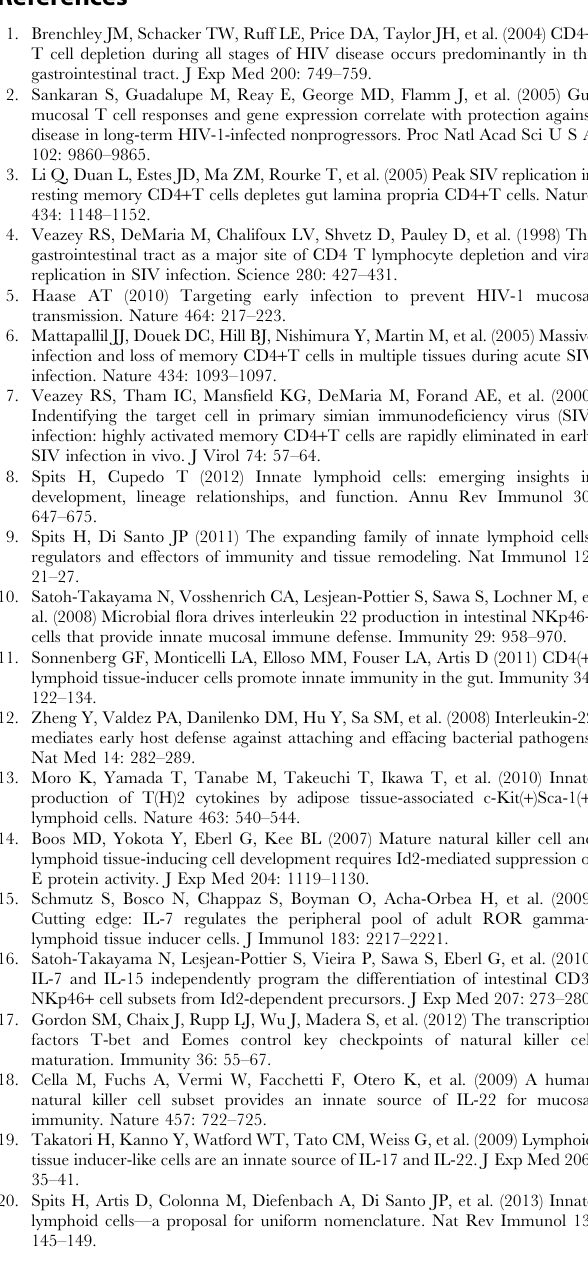
S4 Figure Expression of trafficking markers on circu- lating NK cells. Median fluorescence intensities (MFI) of a 4 b 7 (A), CD62L (B), CCR7 (C), and CXCR3 (D) expression on NK cells in circulating and tissues were compared between naı¨ve and acute SIV-infected macaques. S5 Figure IL-17 production in SIV infection. (A) Mono- functional production of IL-17 by NKp44 + ILCs as shown in Fig. 4. IL-17 concentrations in mucosal washes (B) and plasma (C) during SIV infection. UD, undetectable in all animals. S6 Figure MFI of perforin expression in NK cell subsets in